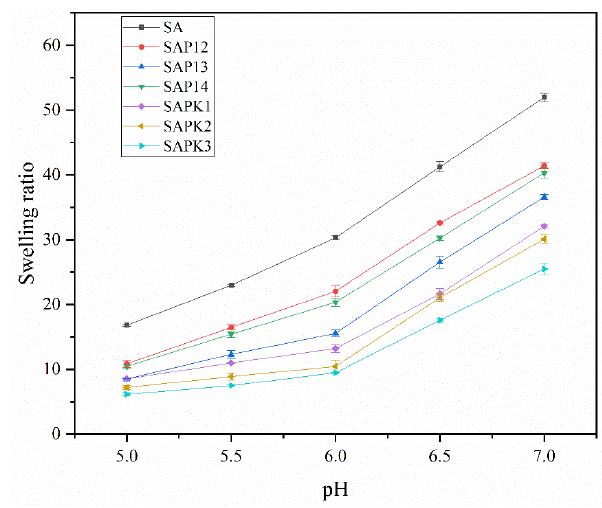
Figure 6. Effect of ionic strength on the swelling behaviors of beads with different compositions.